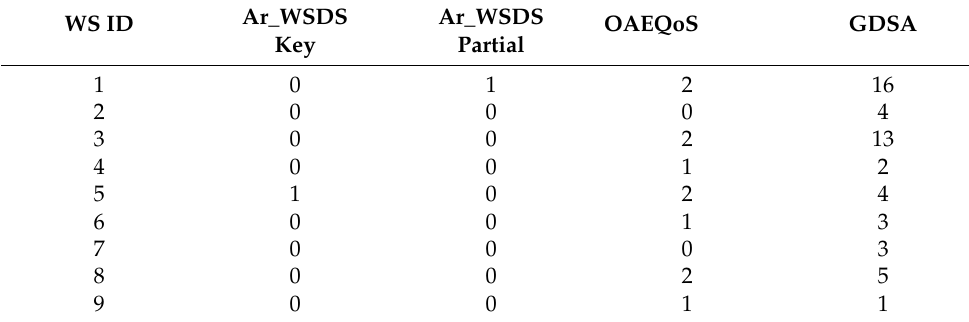
Table 9. Amount of errors in the selection of